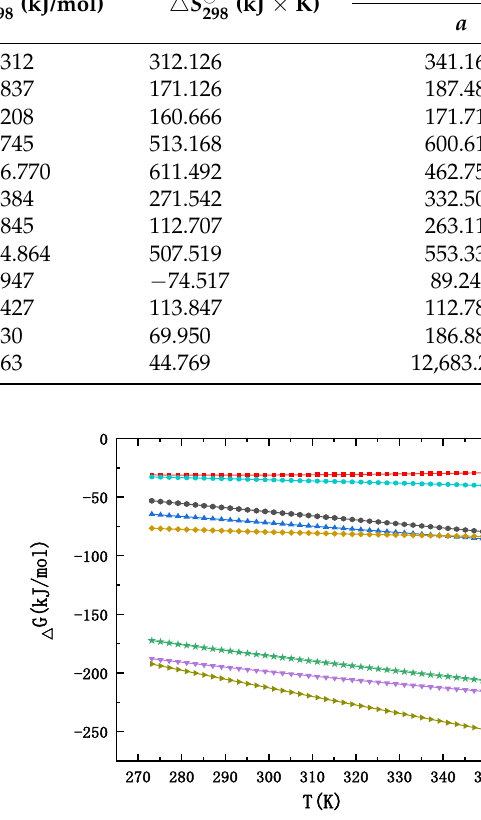
Figure 2. The relationship between the synthesis temperature and Gibbs free